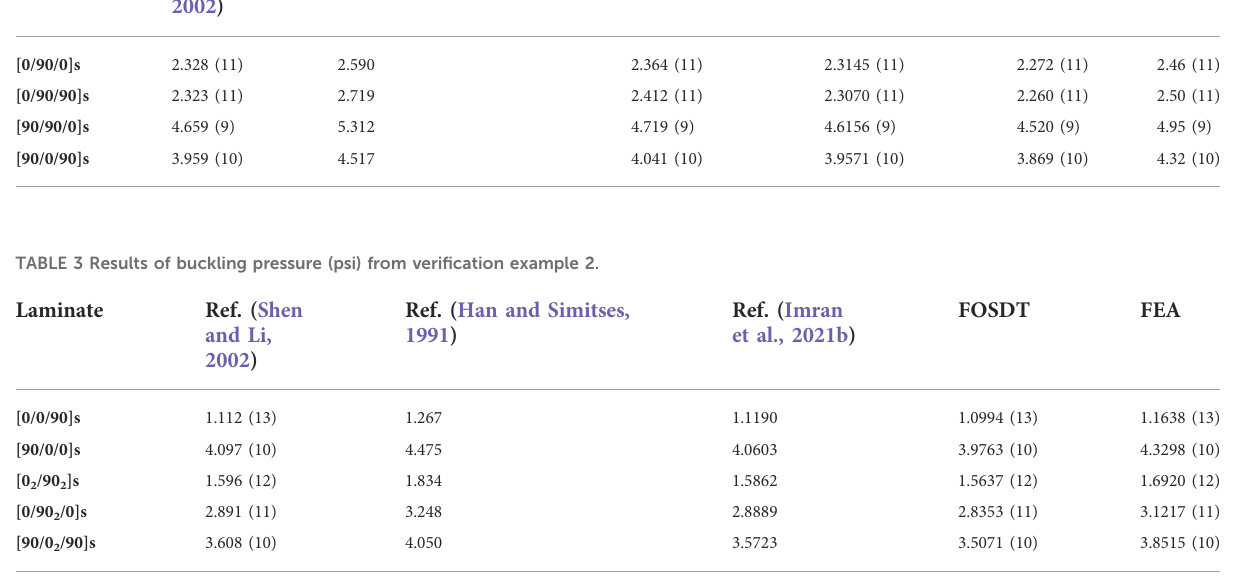
TABLE 2 Results of buckling pressure (psi) from the veri fi cation example 1. Laminate